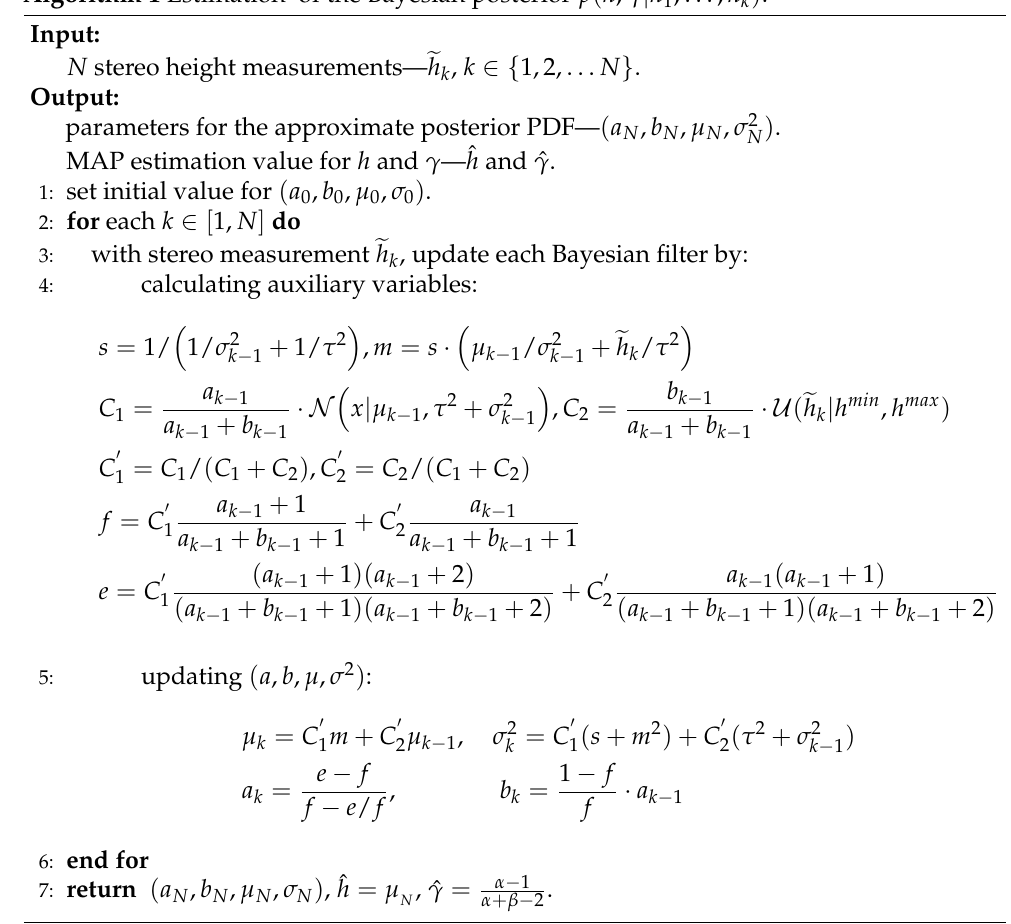
Algorithm 1 Estimation of the Bayesian posterior p ( h , γ | (cid:101) h 1 , . . . , (cid:101) h k )